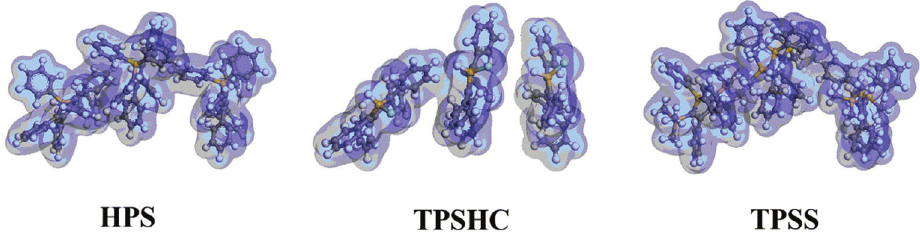
Figure 5: Molecular charge density distribution of HPS, TPSS, and TPSHC in more complex aggregate